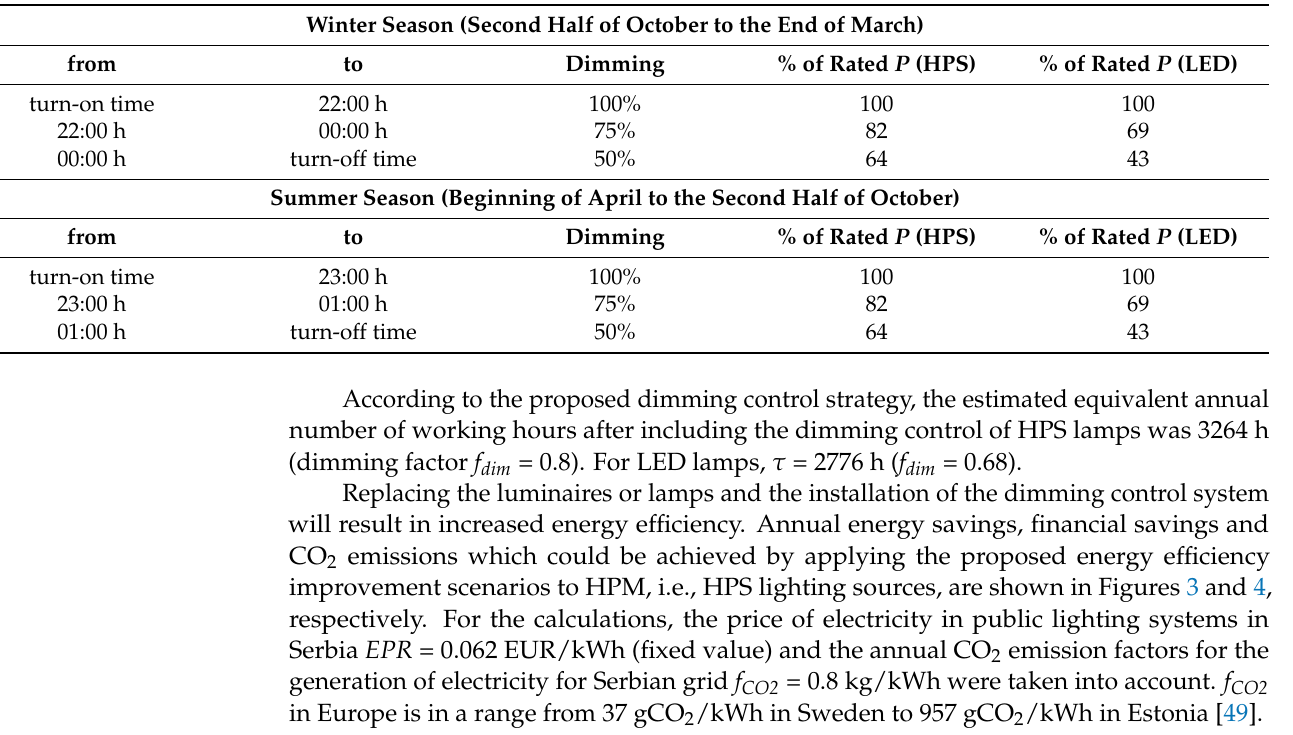
Table 6. The principle of dimming control.